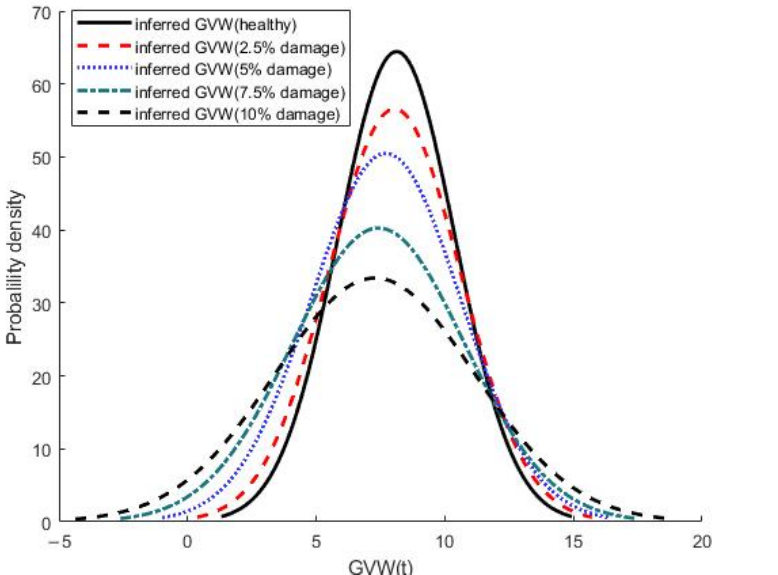
Figure 9. Gaussian curves for batches of 500 inferred GVWs with various sources of inaccuracy. This entire set of simulations, including errors, has been carried out three times to establish the repeatability of the trends. The variations in the means and standard deviations with damage are presented in Figure 10. There is considerable variation in the inferred mean weights—the coefficient of determination (R 2 ) of the trendline (linear regression) is only 0.63. While the general linear trend is clear, the mean inferred GVW does not always decrease with increasing damage. It is also noteworthy that, even for the healthy bridge, the mean GVWs are less than the true mean values which are 8.11 t, 8.31 t, and 8.12 t for Batches 1 to 3, respectively. This appears to be due to the simulated errors in the velocity: when the true velocities are used in the inference of healthy bridge GVWs, the results are 8.80 t, 8.91 t, and 8.95 t, respectively.